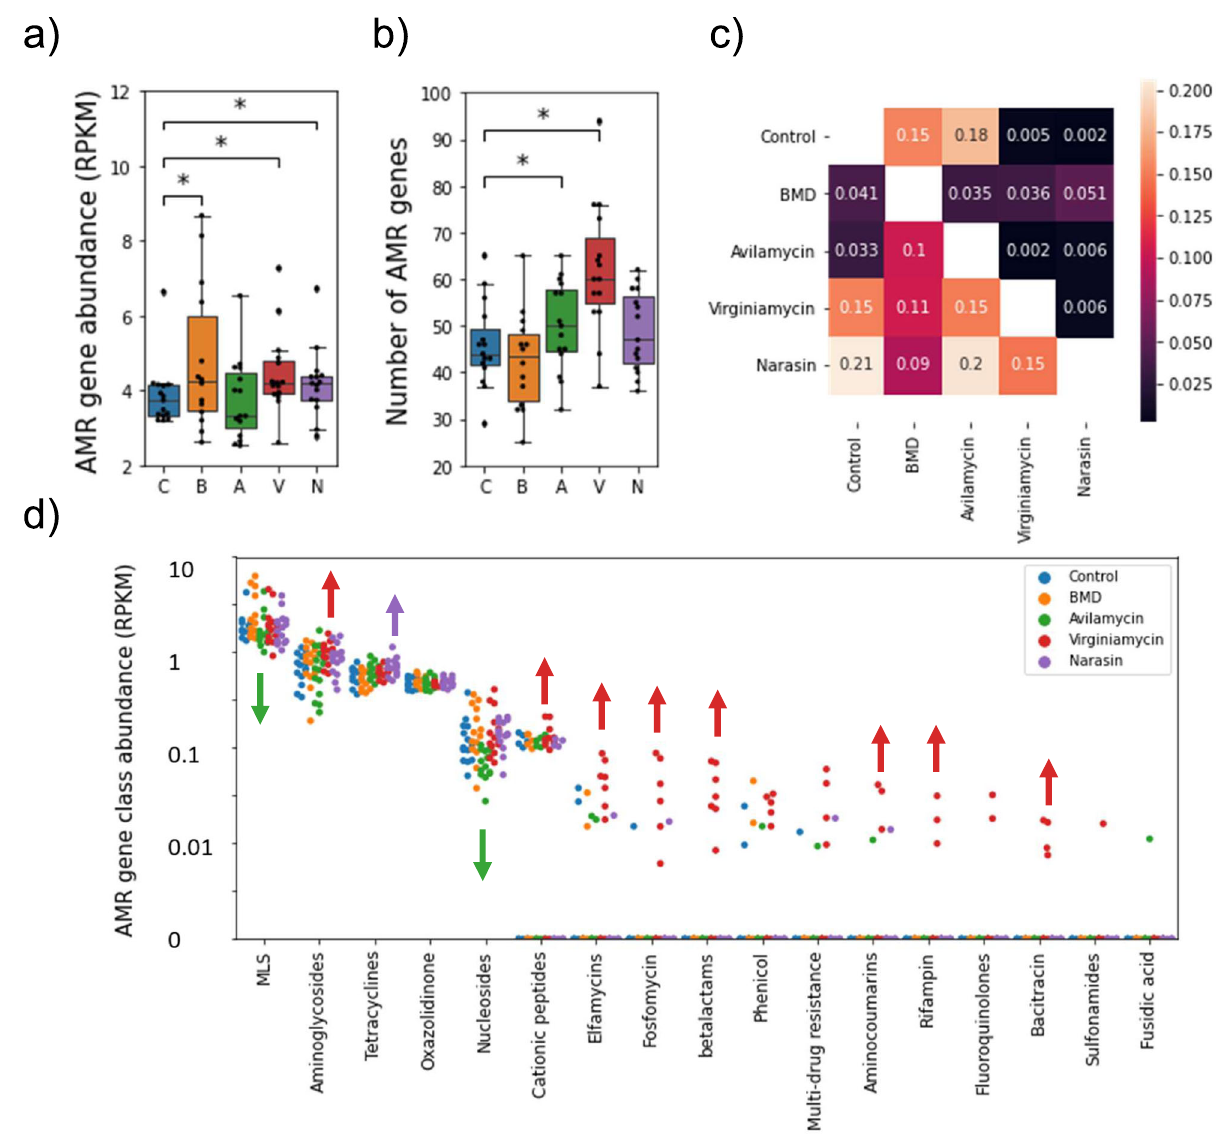
Fig. 4 Antimicrobial resistance gene abundance in the cecal microbiome of birds treated with different AGP. a ) Total AMR gene abundance (RPKM) as a function of treatment group. b ) Number of distinct AMR genes detected as a function of treatment group. * one-sided Mann-Whitney p-value < 0.05. n = 15 birds per group. The boxes in a, and b represent the median and interquartile range; whiskers indicate the range of the distribution excluding outliers. C control, B BMD, A avilamycin, V virginiamycin, N narasin. c ) ANOSIM analysis of the Bray-Curtis dissimilarities between samples in different treatments based on their AMR pro fi les. In the heatmap, values below the diagonal represent the ANOSIM R-score. Lower values indicate more similar AMR pro fi les between treatments. Values above the diagonal indicate the corresponding p-values for the null hypothesis that AMR pro fi les are similar between treatments. d ) Abundance of AMR genes of distinct classes for samples in different treatment groups (colors). Classes are sorted according to their mean AMR gene abundance across samples. Color arrows indicate a signi fi cant (p-value < 0.05) increase (pointing up) or decrease (pointing down) in the abundance of AMRs in the corresponding color treatments compared to control samples. MLS macrolides, lincosamides, and streptrogramin A and